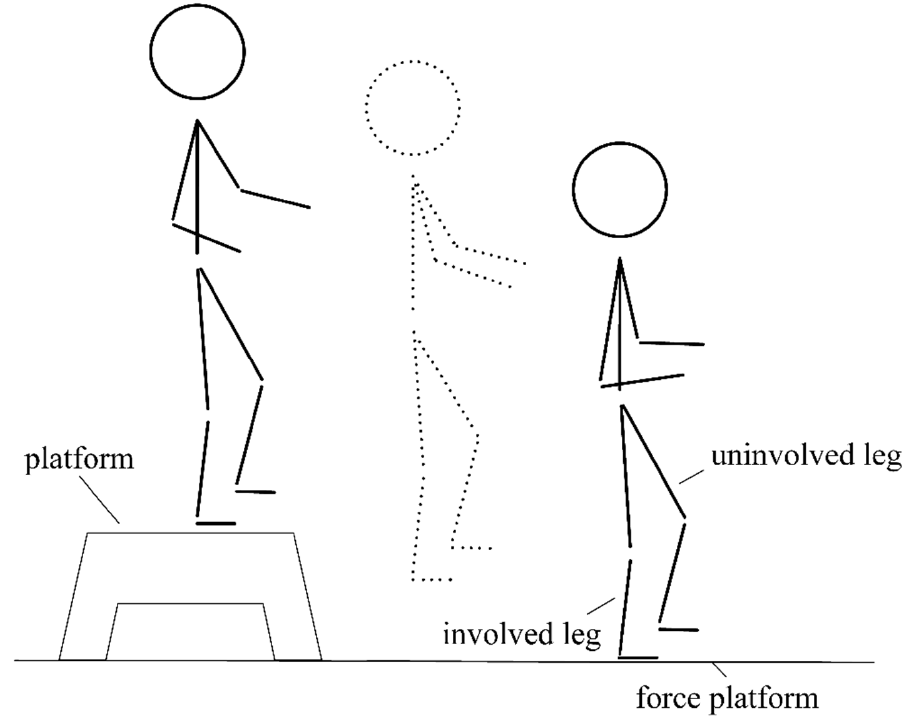
Figure 2. Schematic illustration of single-leg drop jump landing.